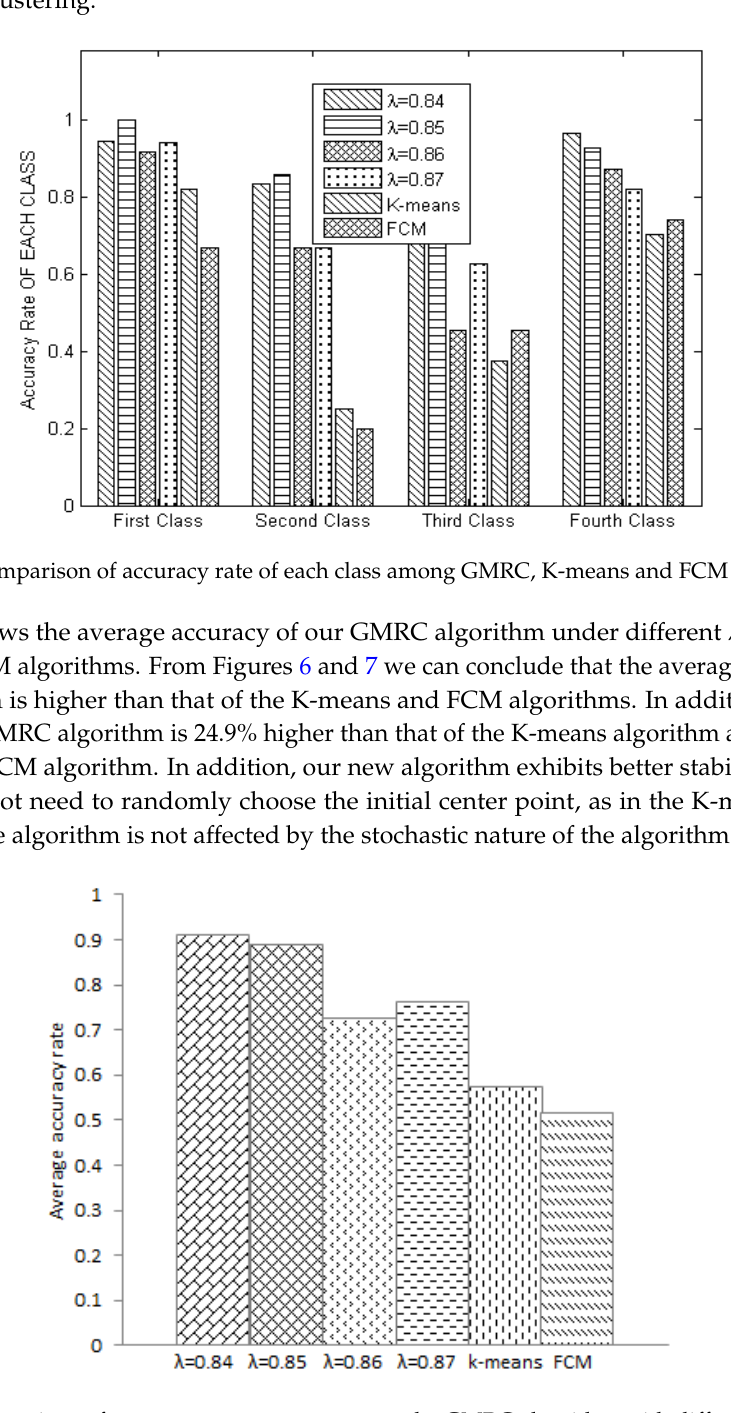
Figure 7. Comparison of average accuracy rate among the GMRC algorithm with different λ and the K-means and FCM algorithms.